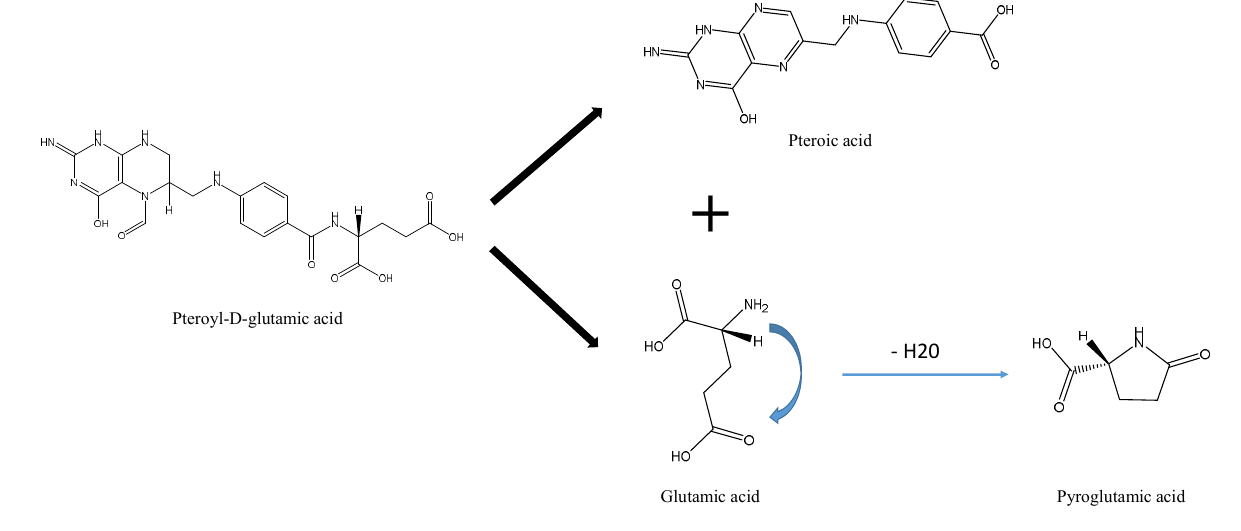
Figure 4. Diagram of pyroglutamic acid production.